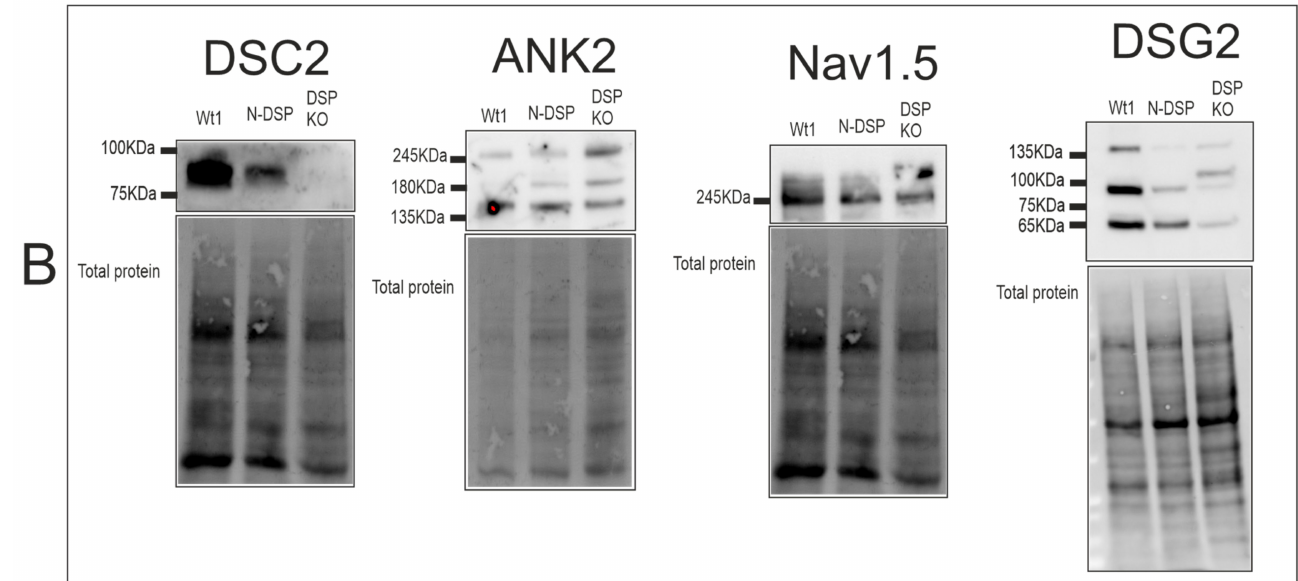
Figure 6. mRNA expression levels of CACNA1C and PLN ( A ) and protein levels of DSC2, ANK2,